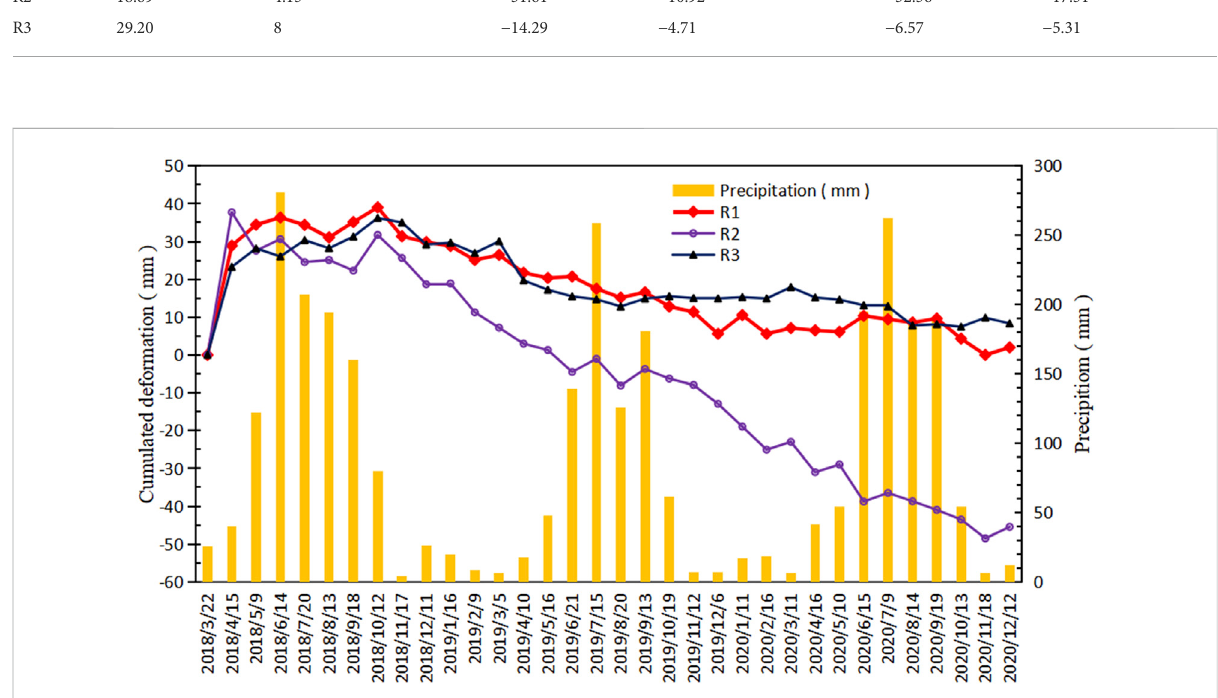
FIGURE 10 Time series deformation of feature points and precipitation in the right